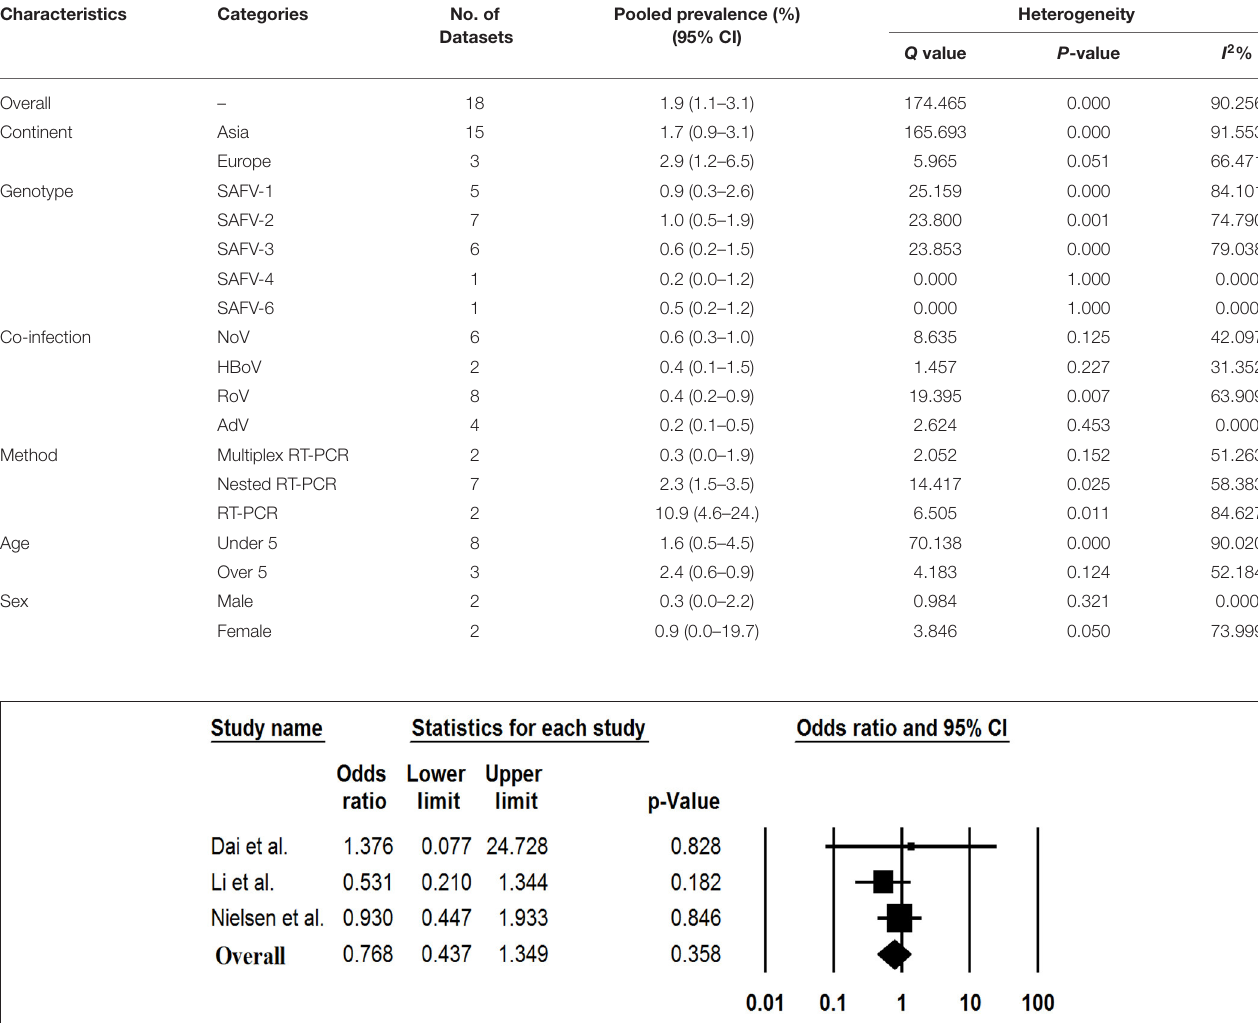
TABLE 5 | The Saffold virus prevalence based on subgroups and studies heterogeneity. Characteristics